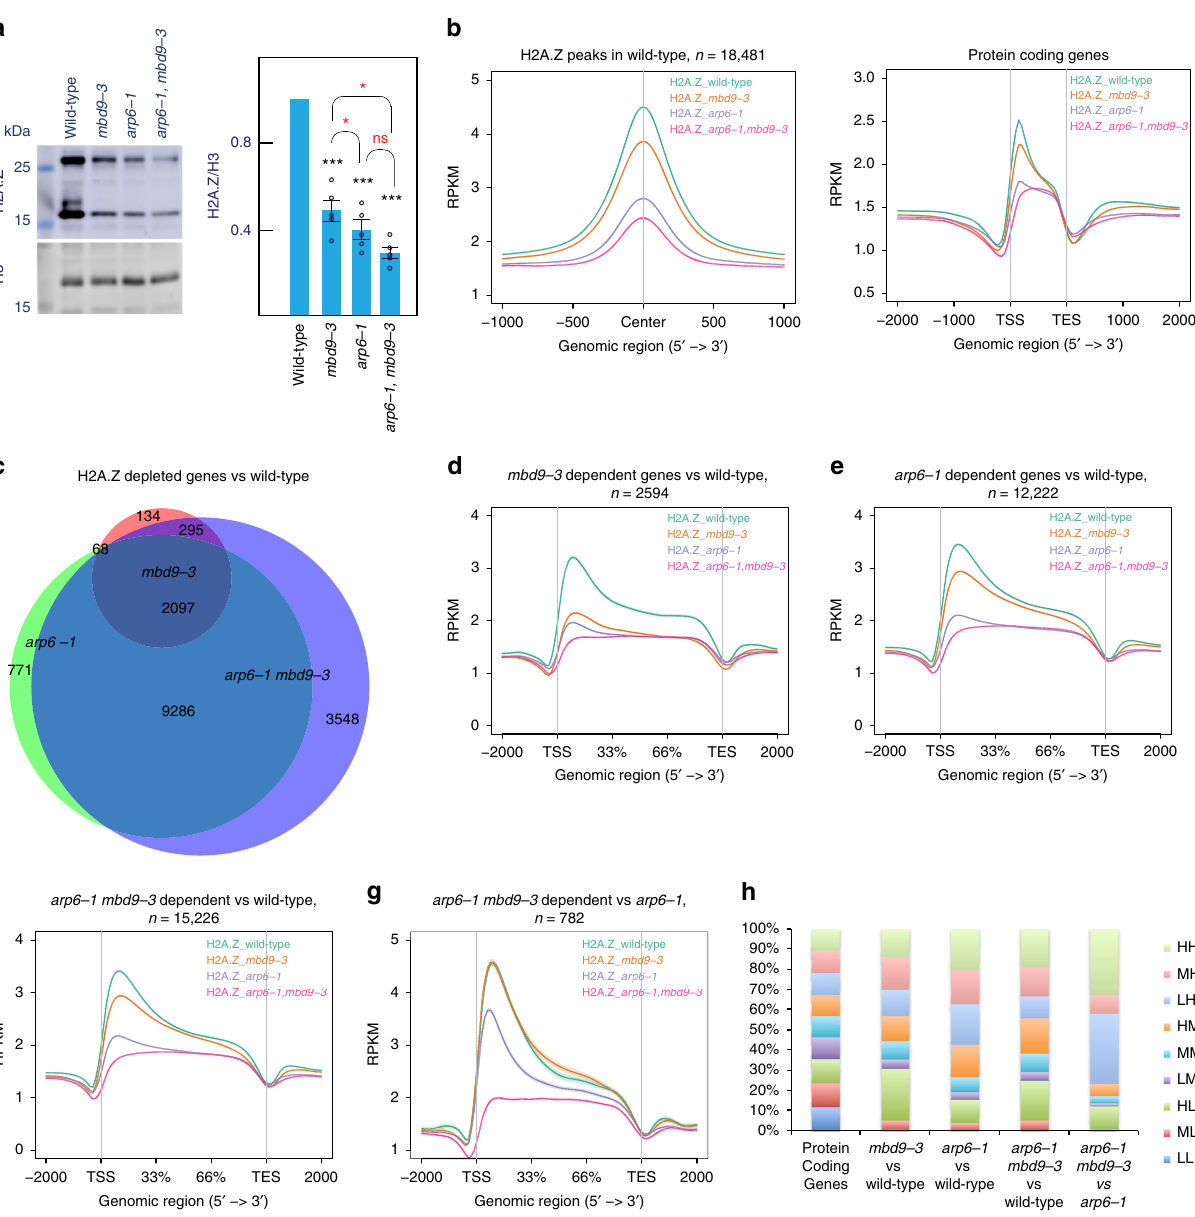
Fig. 2 Characterization of H2A.Z in wild type and mutant chromatin. a Western blot and quanti fi cation for H2A.Z and H3 levels in total extracts from wild type, mbd9-3, arp6-1 , and arp6-1 mbd9-3 . The upper band in the H2A.Z blot likely represents a modi fi ed form of H2A.Z. Only the lower band was used in the quanti fi cation. Average levels of three independent westerns ± standard deviations are shown. Paired two-tailed Student ’ s t -test was used to determine signi fi cance between wild type and mutants (black asterisks) or between mutants (red asterisks); ns p value >0.05, * p value ≤ 0.05, ** p value ≤ 0.01, *** p value ≤ = 0.001. b Distribution of normalized H2A.Z ChIP-seq signal as read count kbp − 1 million − 1 mapped reads (RPKM) from merged replicates over H2A.Z common peaks in wild type and protein-coding genes. c Overlap of H2A.Z-depleted genes for mbd9-3, arp6-1 , and arp6-1 mbd9-3 mutants. d – g Distribution of normalized H2A.Z ChIP-seq signal (RPKM) from merged replicates over H2A.Z-enriched genes for indicated mutants. h Intersection of H2A.Z-depleted genes from d to g with nine classes of genes characterized by their distribution of H2A.Z in wild type at TSS and gene body. Labels H — high, M — medium, L — low refer to levels of H2A.Z at TSS ( fi rst letter) and gene body (second letter). Source data for Figs. 2a and 2c are provided as